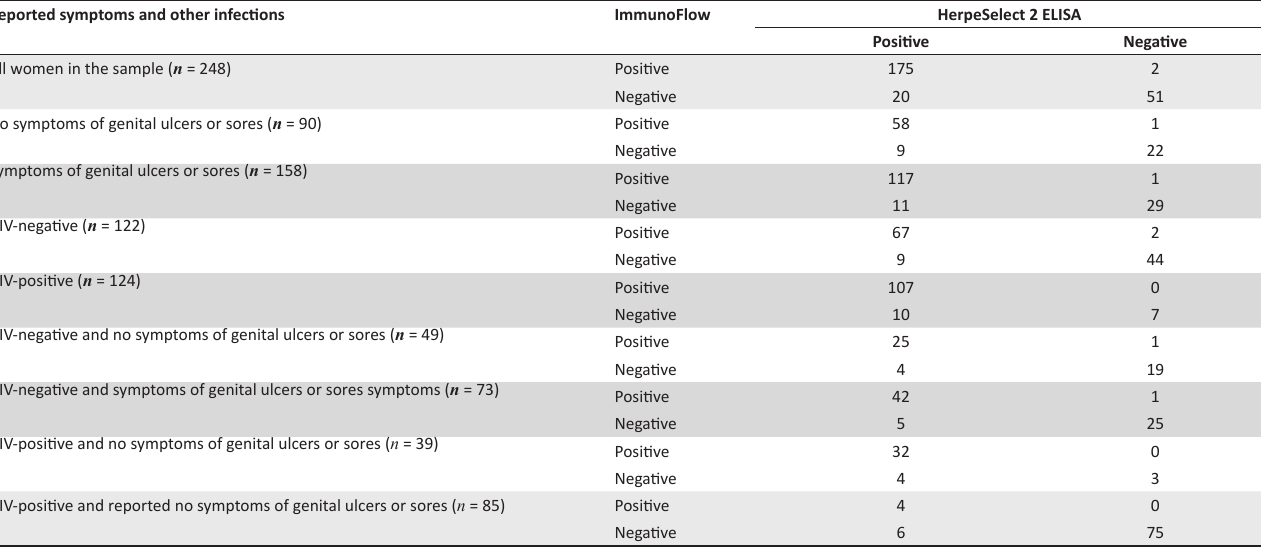
Positive Negative